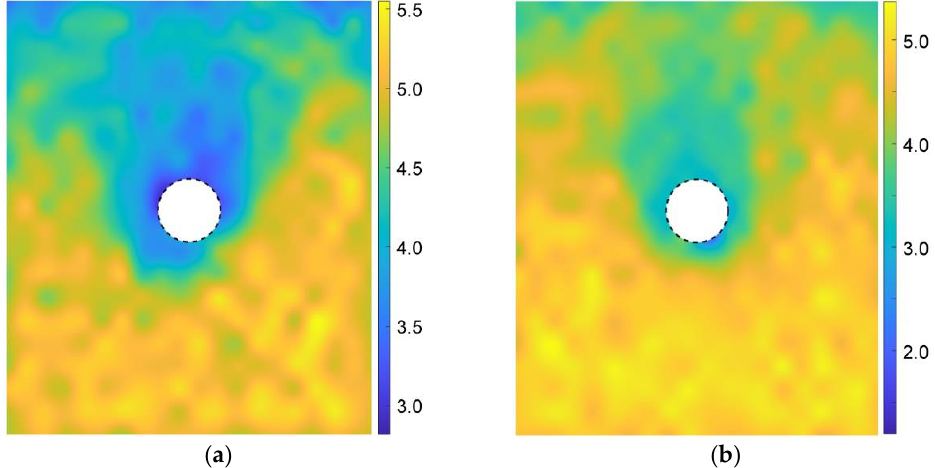
Figure 29. Stress variation angle after the tunnel excavation in the cases of ( a ) AR2C1 and ( b ) AR2C2.